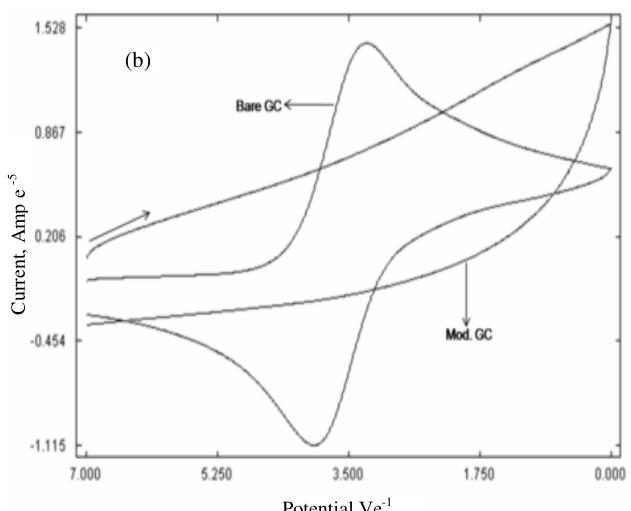
Figure 3 . Overlaying surface voltammograms for HIBD full modification (a) the bare GC and HIBD modified GC with ferrocene and than (b) the bare GC and HIBD modified GC with ferricyanide